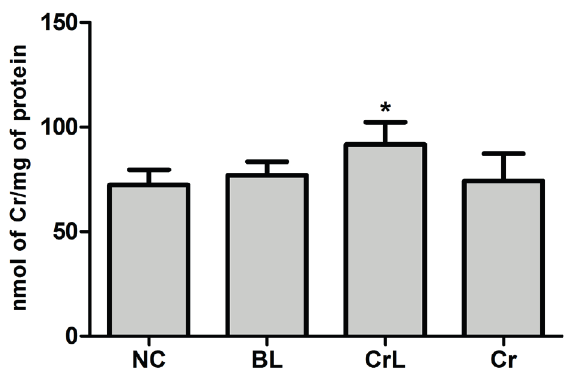
Figure 4 - Creatine concentration in cerebral cortex from adult rats treated. Negative Control (NC), Blank Liposomaes (BL), Creatine Liposomes (CrL), Creatine (Cr). * p < 0.05, compared to the